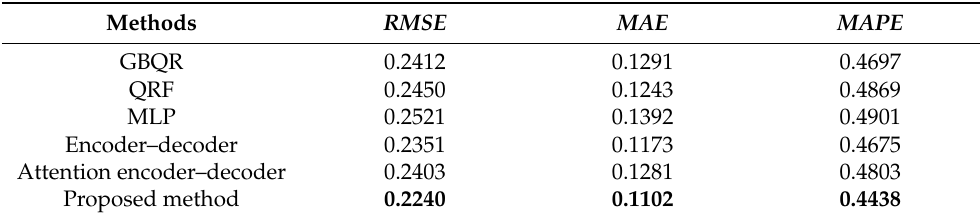
Table 1. Performance comparison of different methods for point forecasting.